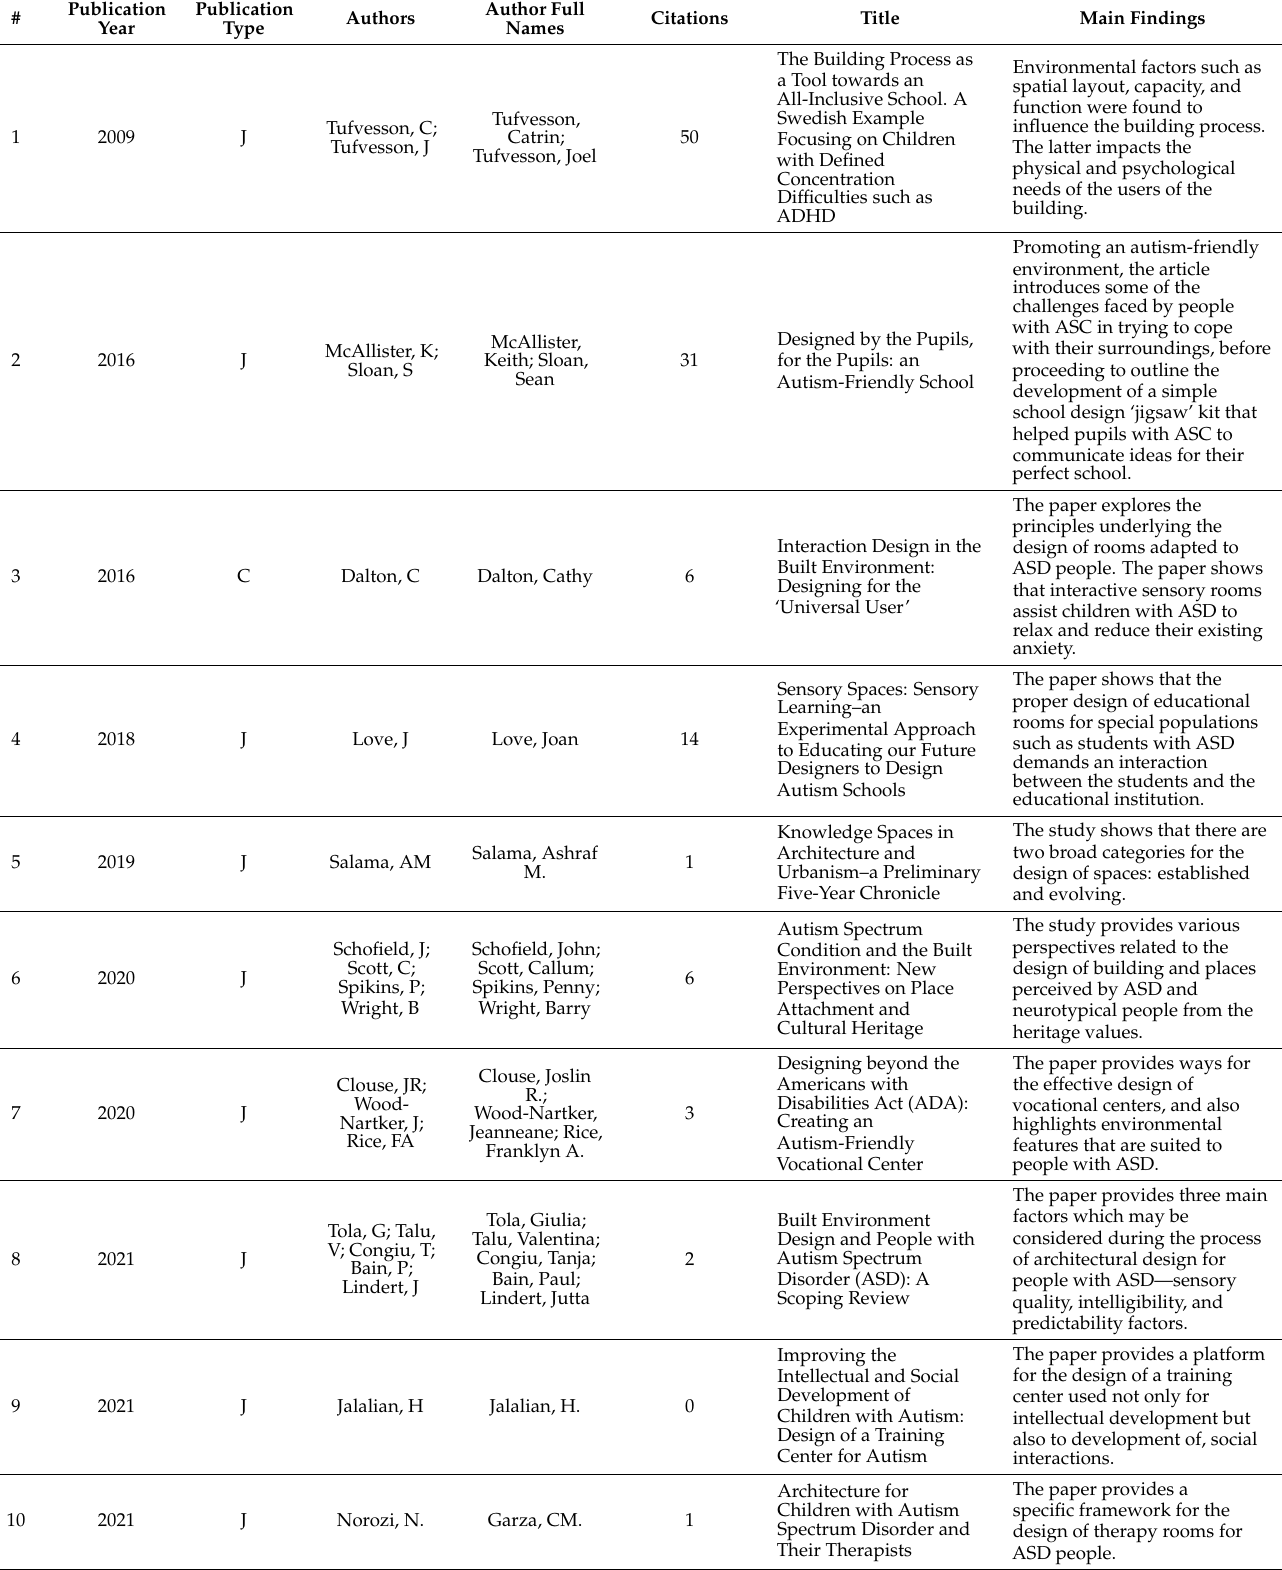
Table 2. WoS papers published in the years